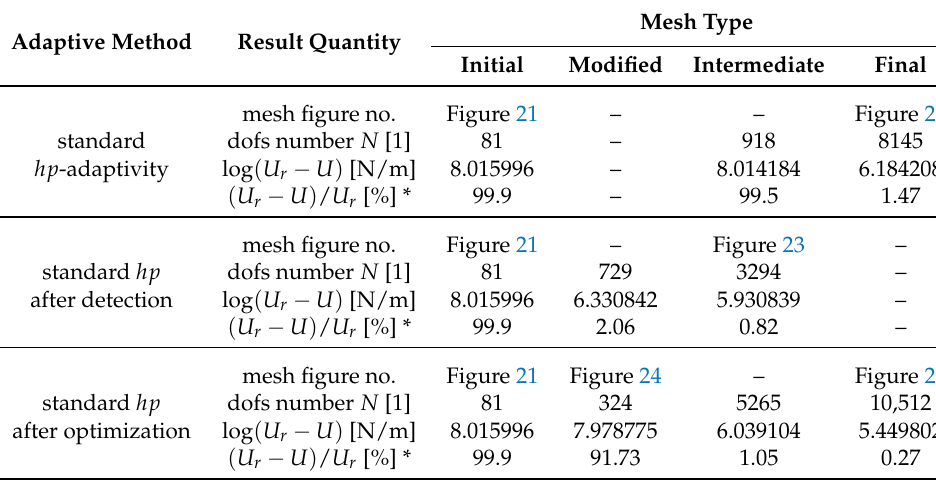
Table 3. Result summary—a quarter of the bending-dominated